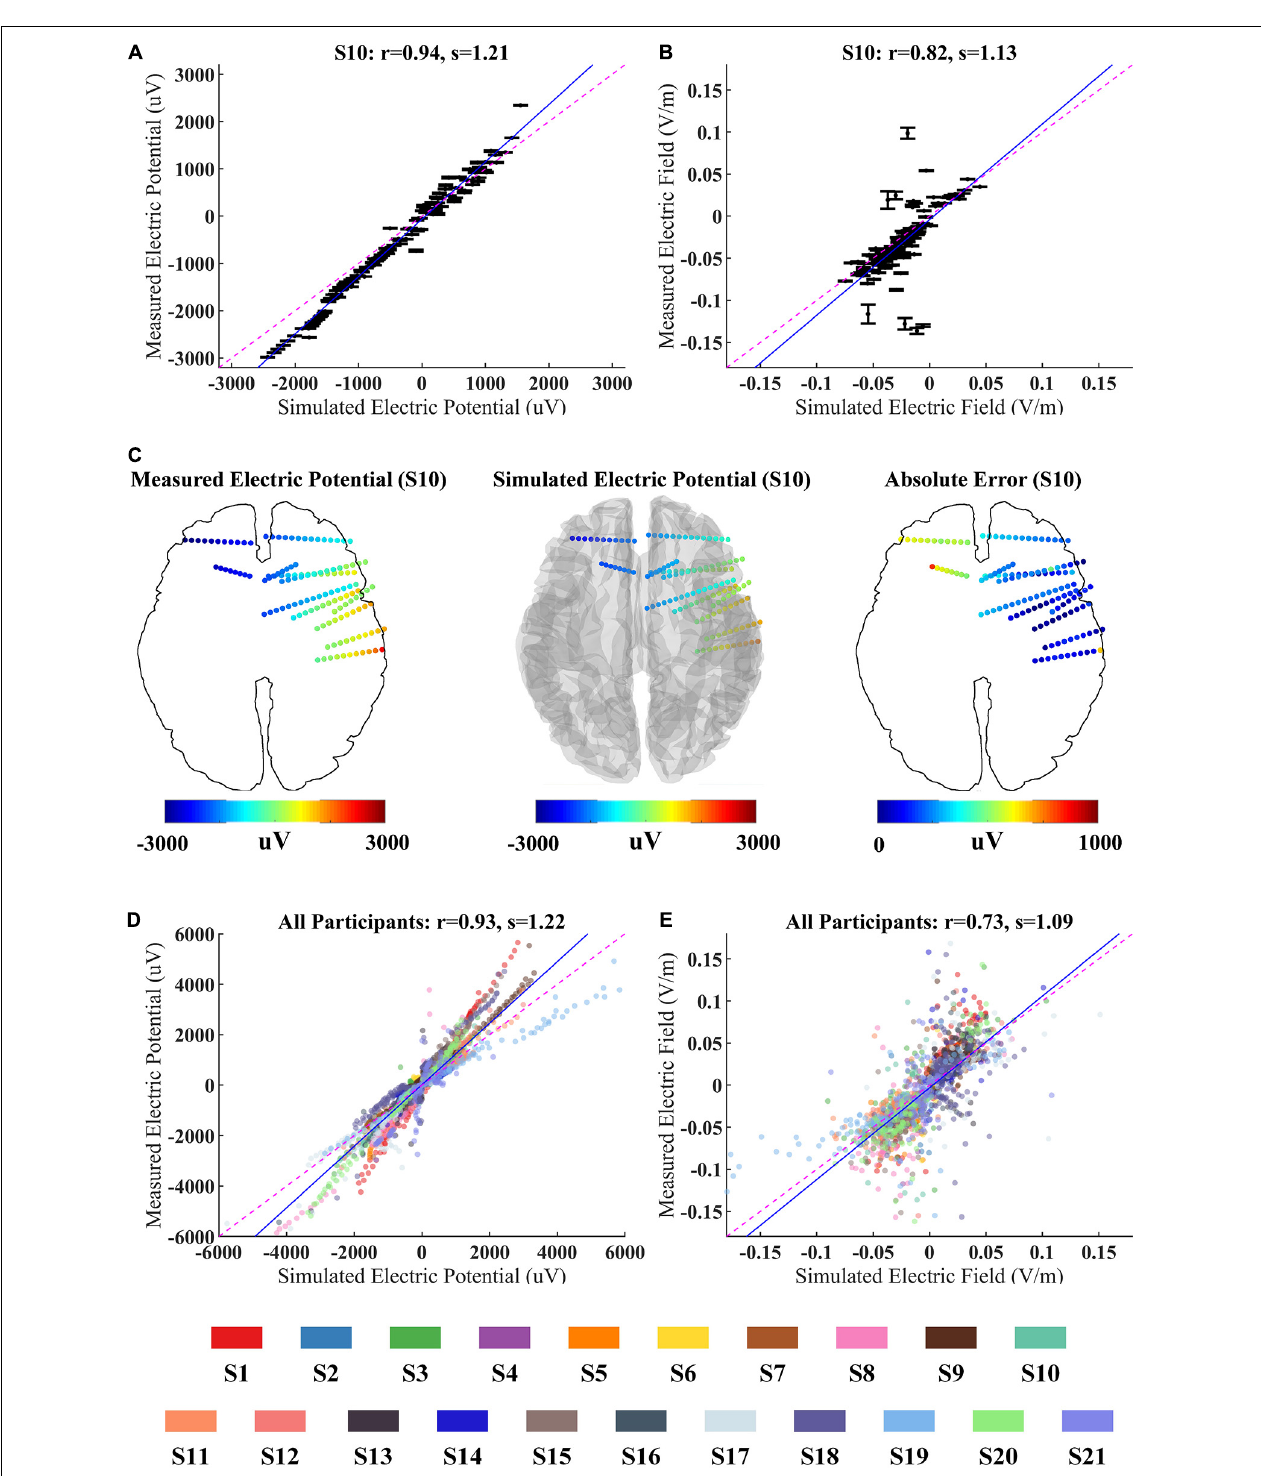
FIGURE 3 | Correlation between simulated and measured values for 100 Hz/500 µ A stimulation. (A,B) The measured voltages and projected electric fields (EFs) with simulated values from individualized model for S10. Error bars at each electrode indicate the variability across three repeated stimulation trials. (C) The spatial electric potential distributions from recorded and simulated results for S10. (D,E) Comparison of recorded voltages and projected EFs with predicted values for all participants. The data from different participant were represented by the color-coding of participants at the bottom of the figure. Points falling on the magenta line represent perfect prediction (slope s = 1). Blue line represents fitting